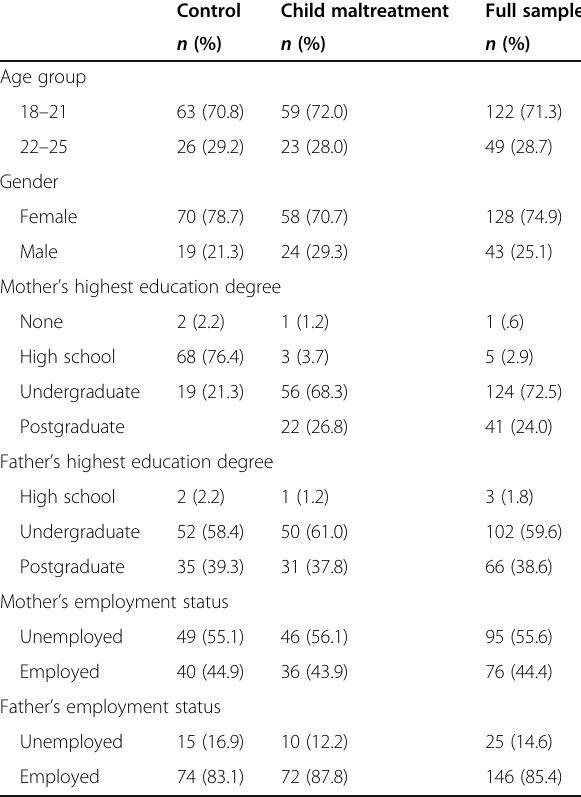
Table 1 Sample demographic